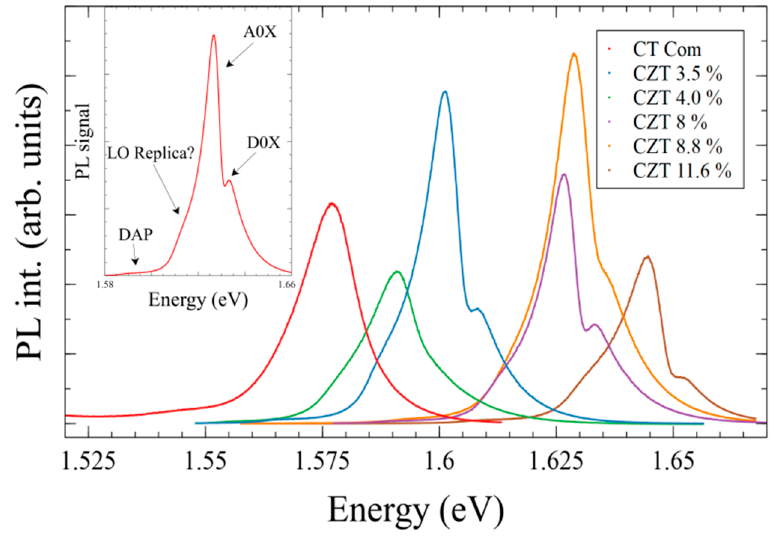
Figure 11. Photoluminescence spectra of wafers with different Zn composition, obtained at 76 K. Inset: Peak assignment in the spectra of the wafer with 8.8 at% Zn.